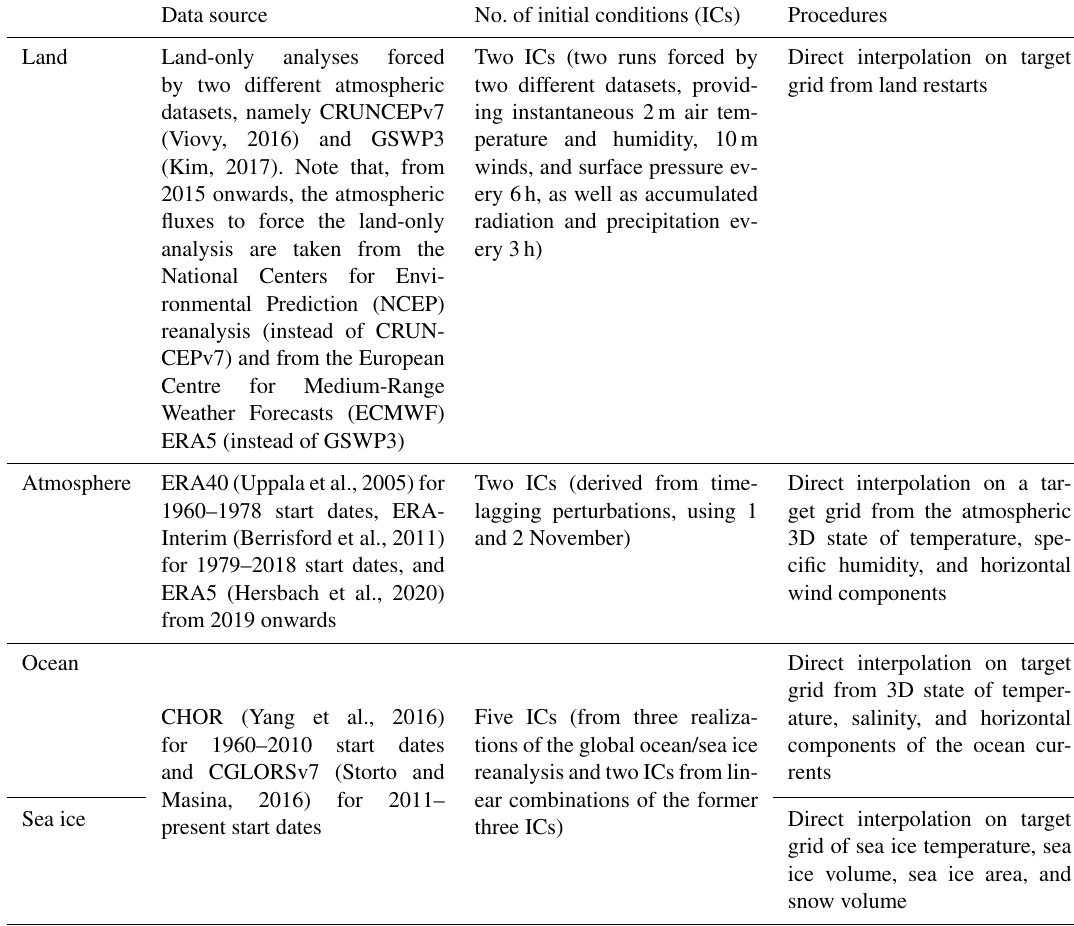
Table 1. List of initial conditions used for the generation of the 20-member hindcast ensemble. Data source No. of initial conditions (ICs)